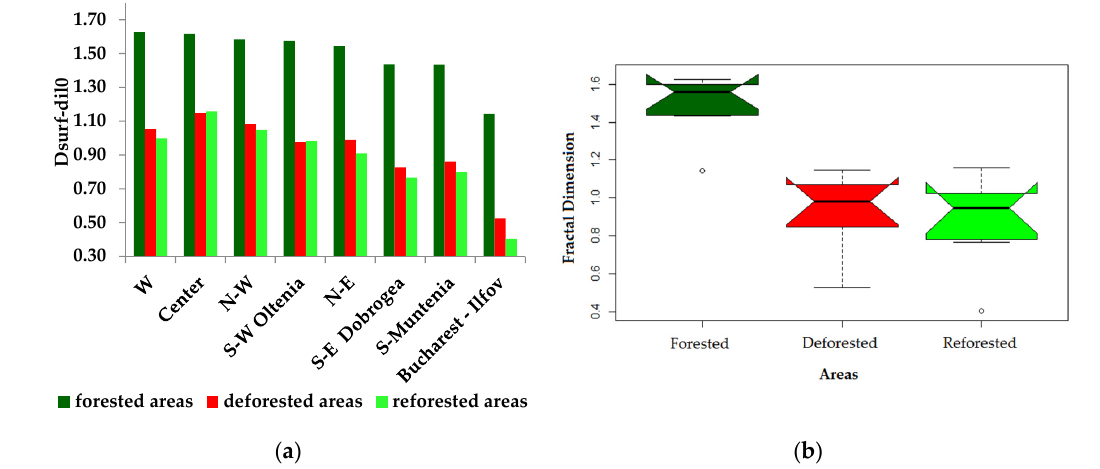
Figure 3. ( a ) D Surf ‐ dil0 of forested, deforested and reforested areas from development regions of Romania DRs of Romania. ( b ) Boxplots with notches represent the median, interquartile and extreme values of D Surf ‐ dil0 of forested, deforested and reforested areas from DRs of Romania. The fractal dimension of deforestation indicates the fact that the highest values of D Surf ‐ dil0 are found in the Central, North ‐ West and West regions which reveals a greater volume of exploited timber and that deforestation occurred in a rather unstructured manner. The lowest values of fractal dimensions from South Muntenia, South ‐ East Dobrogea and Bucharest ‐ Ilfov regions were caused by the limited areal extent of forests (Figure 4b).